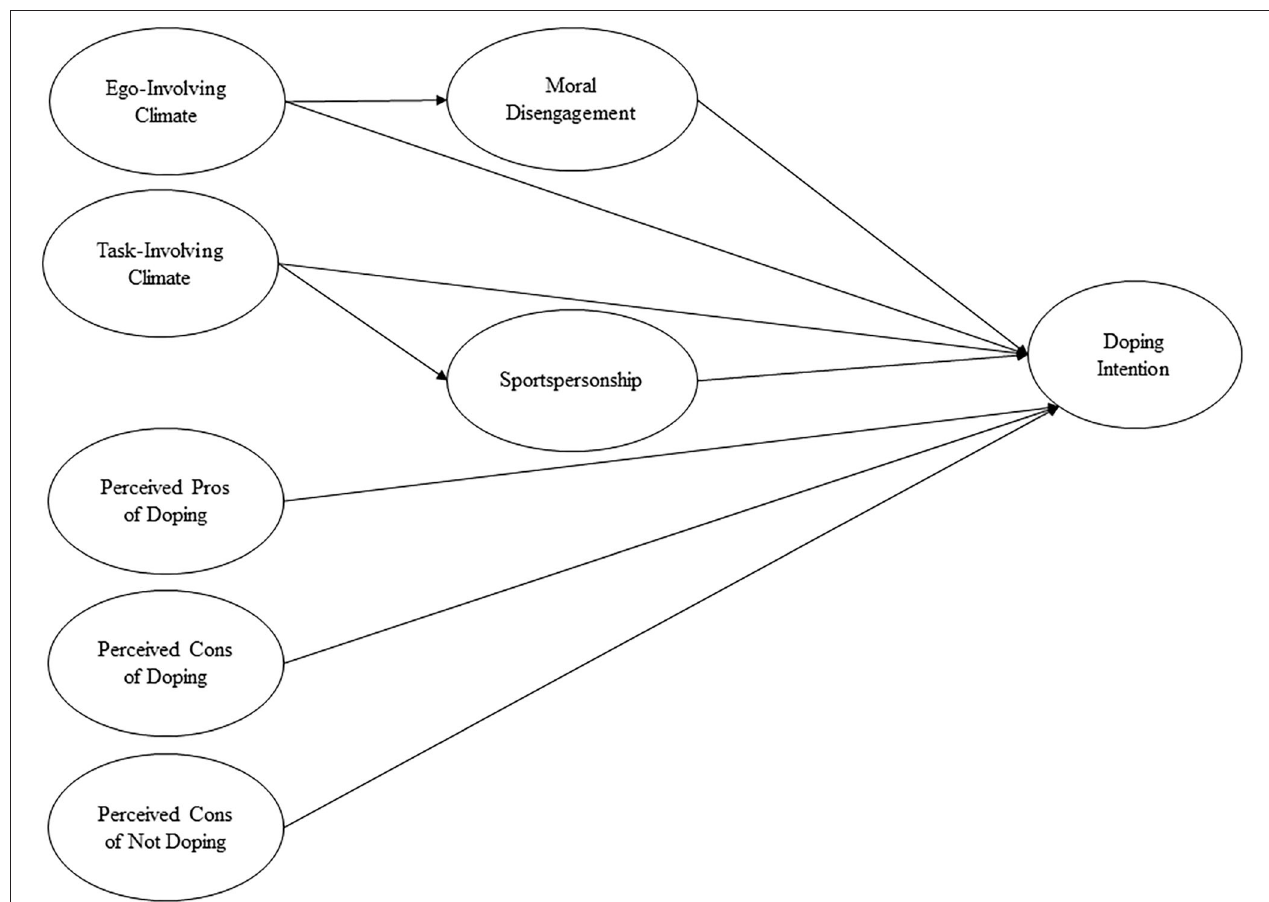
FIGURE 1 | Hypothesized psychosocial model of doping